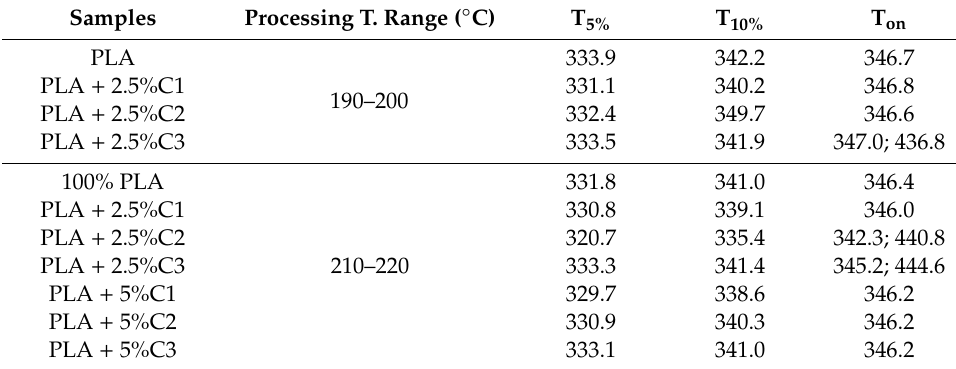
Table 2. Degradation temperatures (T x% ) and onset temperature (T on ) of extruded PLA samples with or without di ff erent compatibilizers.